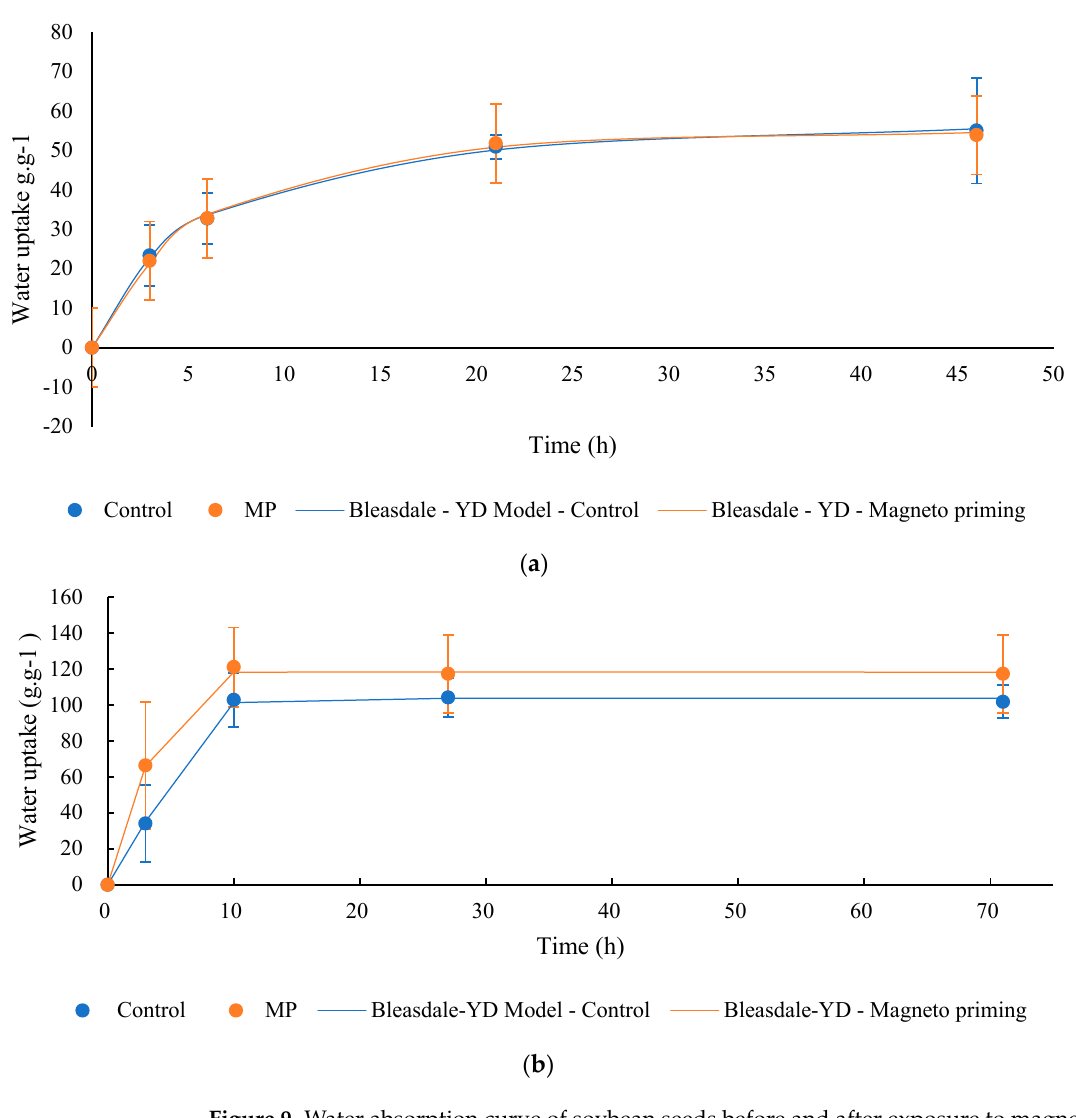
( d ) Figure 8. ( a – d ) represent the test of fresh mass and dry mass of cultivar C02. The differences were analyzed using the Mann–Whitney U test at a significance level of 0.05. The media, data, and p value are represented in the figures for the x, dots, and letter p , respectively. For the germination process to begin to occur in soybean seeds, it is necessary that a